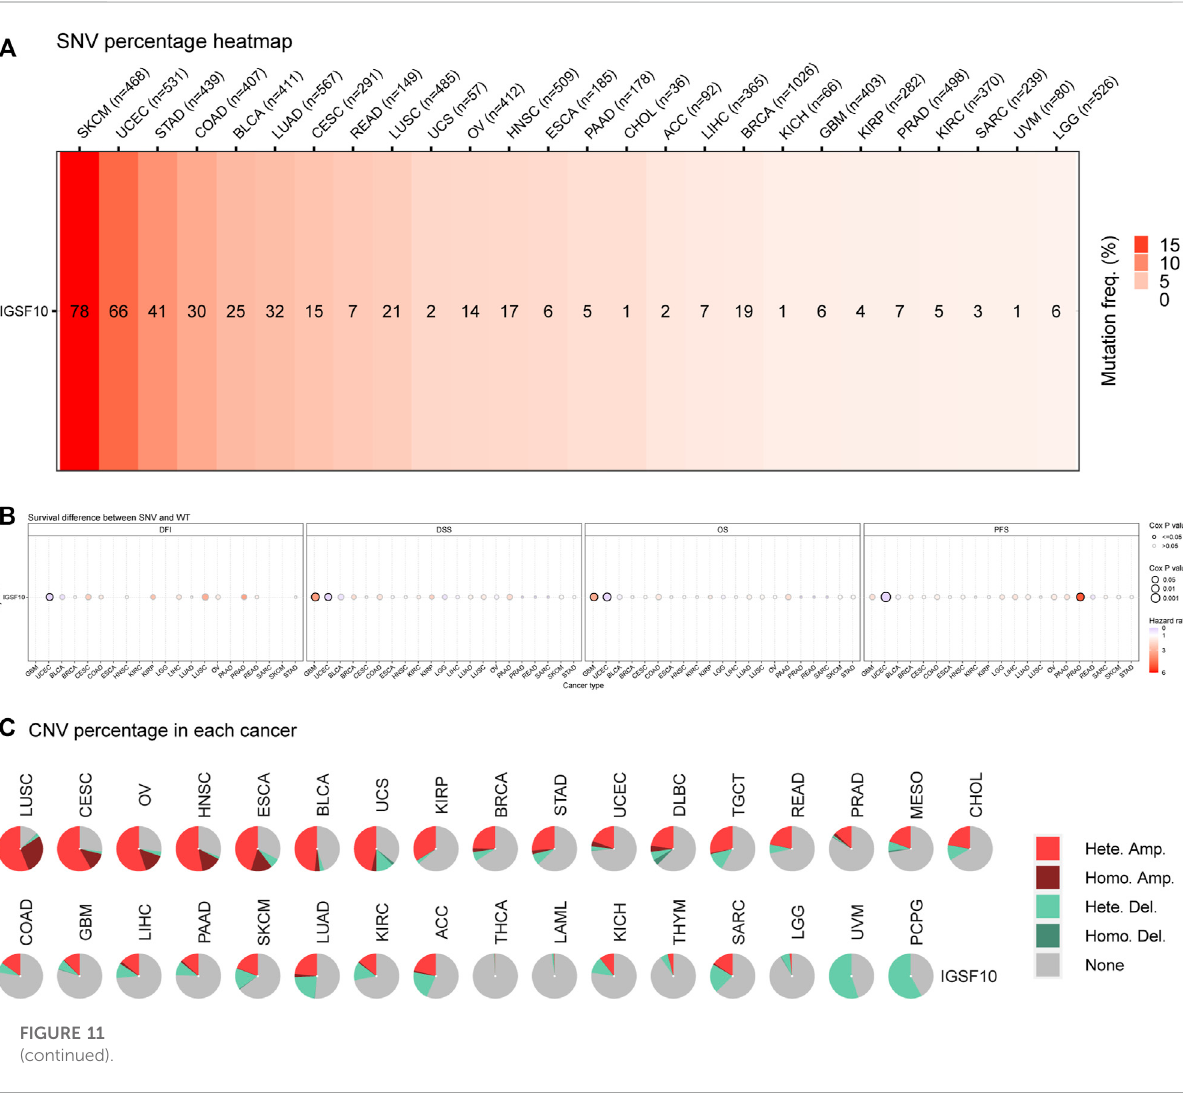
Figure 12C, patients with hypermethylation of IGSF10 had a good prognosis in KIRP, LGG and PAAD, but the opposite trend in